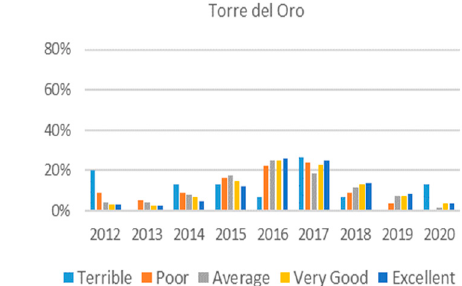
Figure 8. Normalized percentage of ratings offered in each case of study.